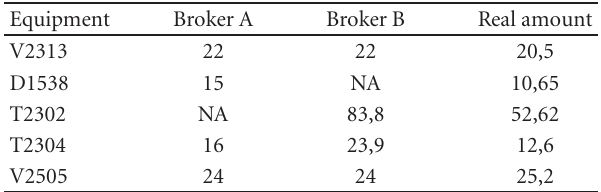
Table 5: Releasable inventory [m 3 ] used as starting points for